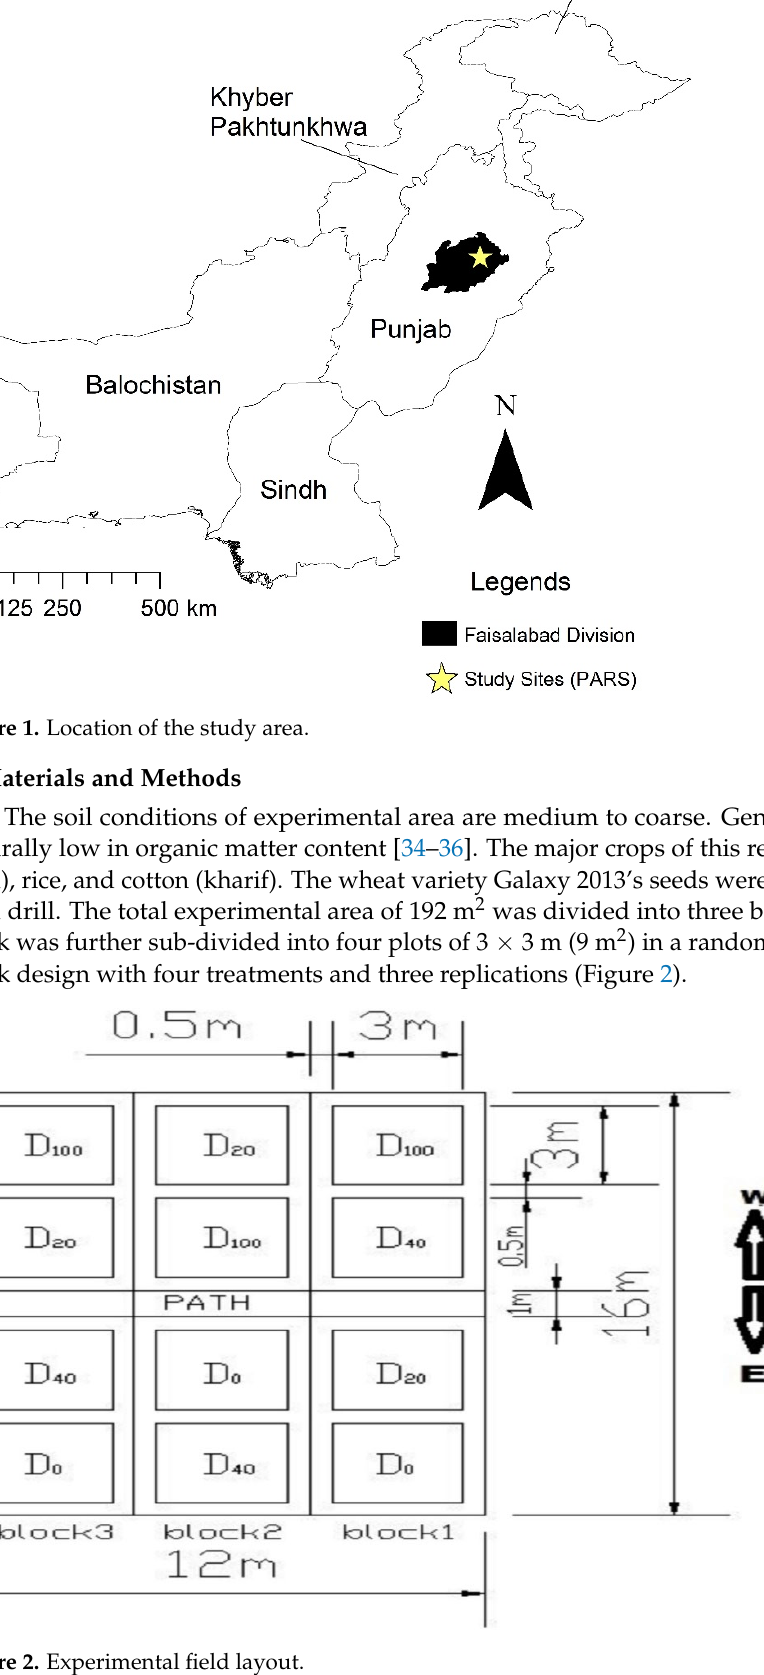
Figure 2. Experimental field layout.